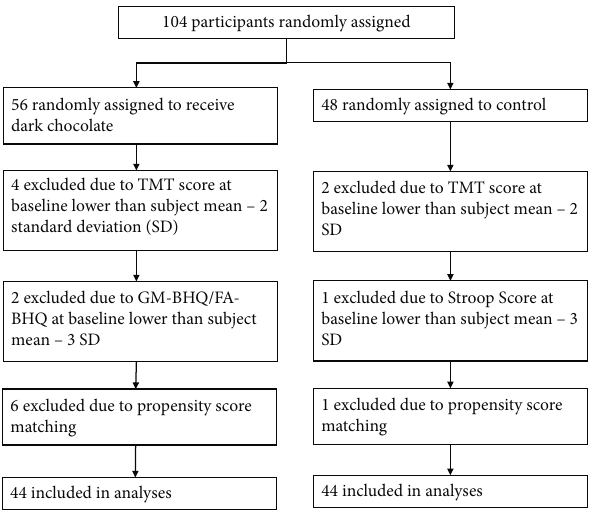
Figure 1: Flow diagram of the